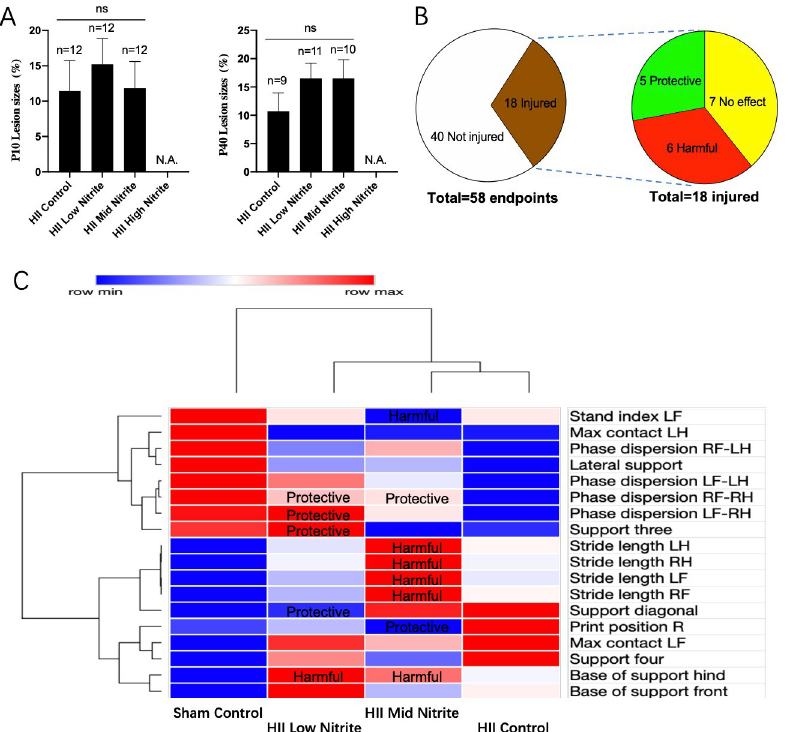
Fig 3. Effects of nitrite on neonatal HII. A) TTC-detected brain infarct size (as a percent of total brain volume) at P10 (left) and P40 (right). Nitrite at high dose resulted in death of all pups. B, C) Neurobehavioral effects of nitrite on HII at P40. B) In 58 gait endpoints, HII resulted in injury in 18, in which nitrite was protective in 5, harmful in 6, and not effective in 7. C) Heatmap of the quantitative gait analysis of the nitrite effects on HII injury. Group means were plotted with the minimum and maximum in each row assigned as blue and red, respectively, and analyzed by hierarchical clustering. Protective and harmful represent mitigation and deterioration of HII-induced alteration, respectively. RF: Right forepaw, LF: Left forepaw, RH: Right hindpaw, LH: Left hindpaw. Descriptions of gait endpoints and detailed data see S1–S3 Tables.